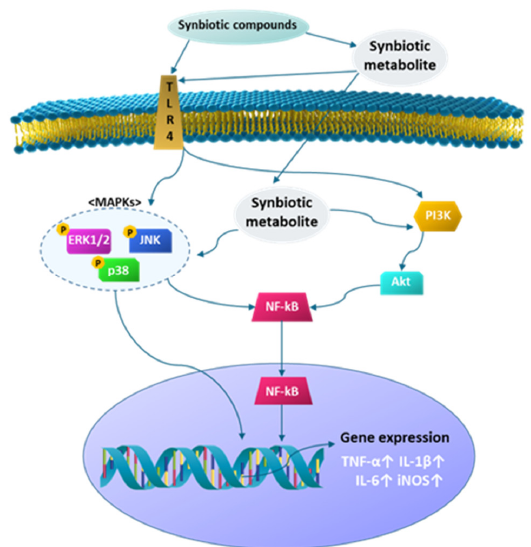
Figure 6. Proposed mechanism for the immunostimulatory activity of synbiotics consisting of glucooligosaccharides and L. lactis SG-030 in RAW 264.7 macrophages. TLR4, toll-like receptor 4, NF-κB, nuclear factor kappa-light-chain-enhancer.